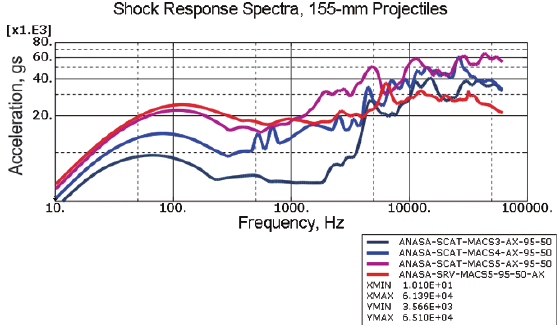
Fig. 14. Comparison of normal tolerance limits, MACS 3, 4 and 5; transverse, Q = 10. (The blue curve is the SRS for the near-tactical MACS 5